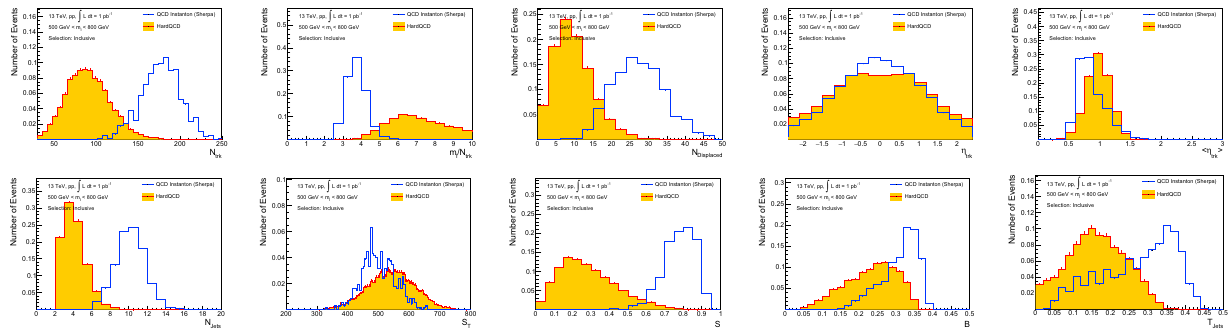
Fig. 5 The production cross section of Instanton processes in proton proton collisions at comparison of the cross section dependence on